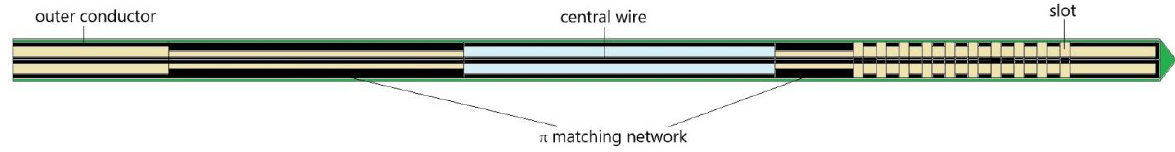
Figure 1. Schematic view of the 10-slot microwave antenna with an impedance match network. Black, green, light blue, and brown colors correspond to conducting material, Teflon, air, and dielectric, respectively. The width of the slot is 0.6 mm, while the spacing between slots is 0.8 mm.